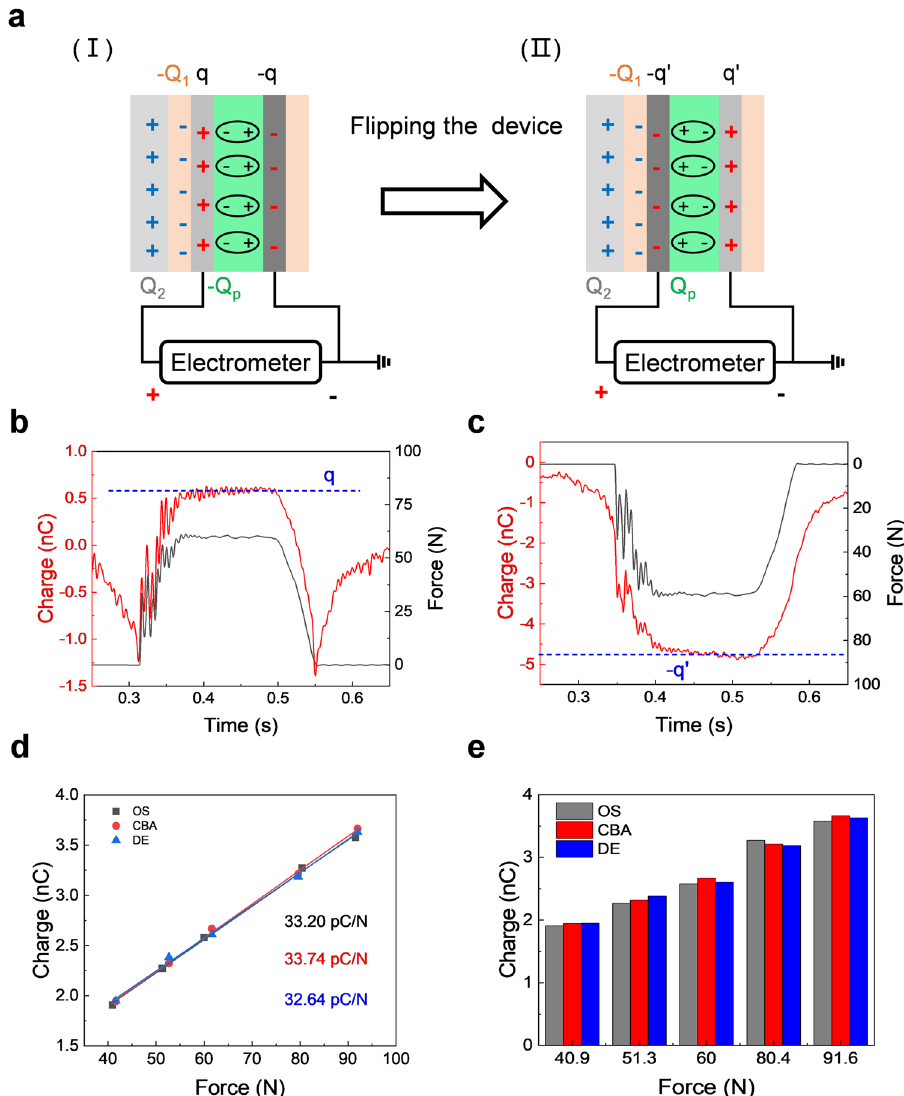
Fig. 5 Evaluating the piezoelectric performance of PVDF fi lm by extracting the piezoelectric charge transfer from the hybrid output. a The electrostatic balance is achieved when the Al plate and the PVDF-based device are contacted. I represent the positive polarization, II represents the negative polarization, Q 2 is the total charge in the Al plate, (cid:1) Q 1 is the total charge in the Kapton layer, q is the charge transfer between electrodes in the positive polarization, Q p is the induced piezoelectric charge, (cid:1) q 0 is the charge transfer between electrodes in the negative polarization. The transferred charges between electrodes are measured from the b positive and c negative polarization sides of PVDF-based device, and the applied force is 60 N. d The charge – force curves of PVDF-based device are obtained by three methods including outside shielding (OS), compressed balance analysis (CBA), and directly extracting (DE). The effective d 33 of OS is 33.20 pC/N, that of CBA is 33.74 pC/N, and that of DE is 32.64 pC/N. e The piezoelectric charge transfer under different forces is obtained by three methods including OS, CBA, and DE. They are almost